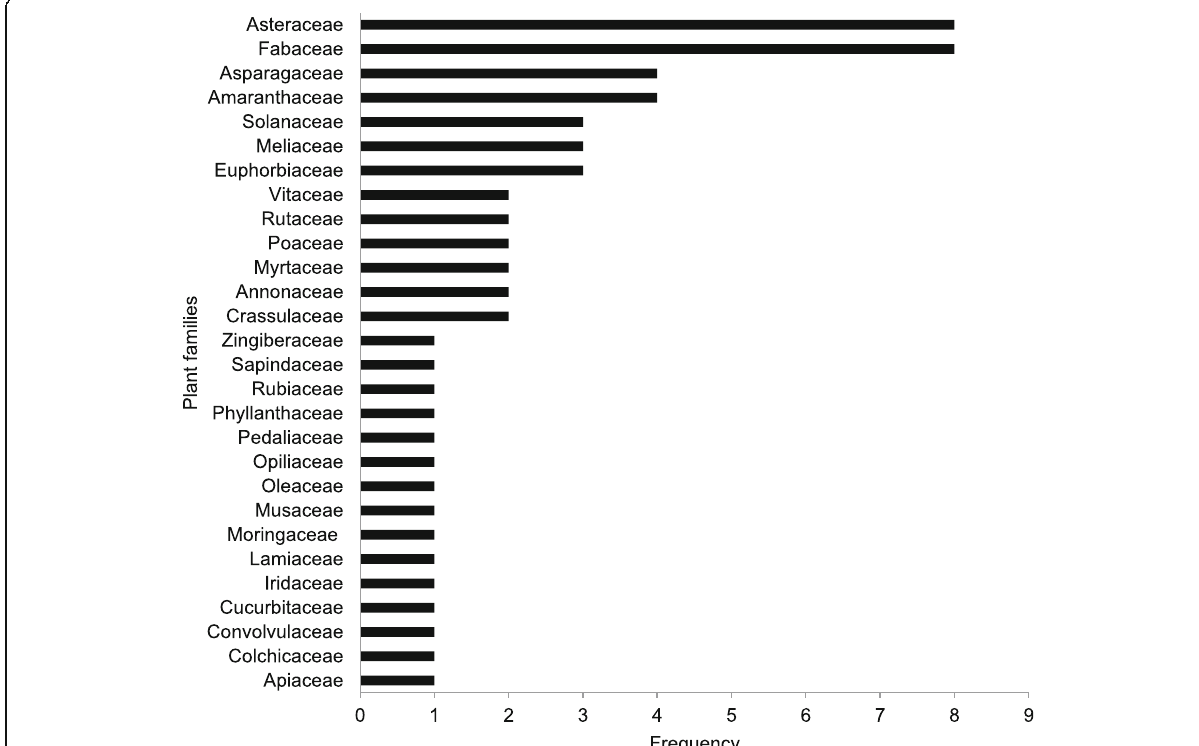
Fig. 1 Families of medicinal plant species used in the management of snakebite envenomation in the Acholi, Teso and Karamoja sub-regions of